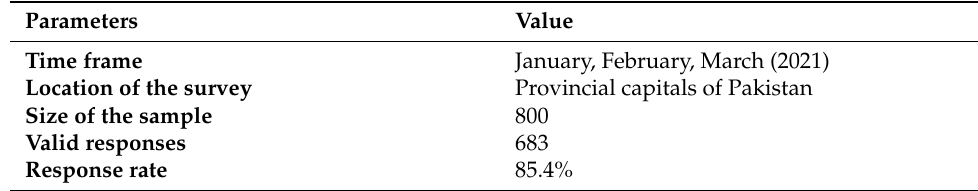
Table 2. Survey description.